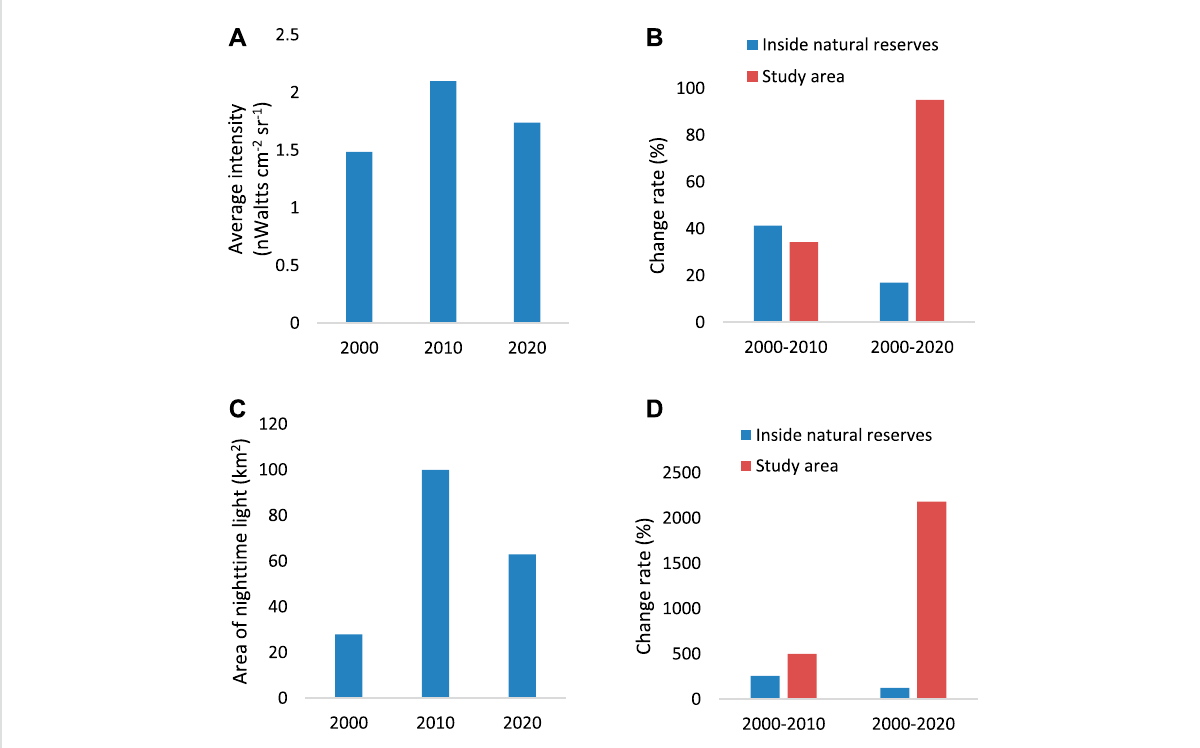
FIGURE 5 Intensity and area of nighttime light inside natural reserves. (A) Average intensity of nighttime light inside natural reserves; (B) Comparison of change ratesofaverageintensity insidenaturalreserves andthewhole studyarea; (C) Areaofnighttimelightinside naturalreserves; (D) Comparison of change rates of nighttime light area inside natural reserves and the whole study